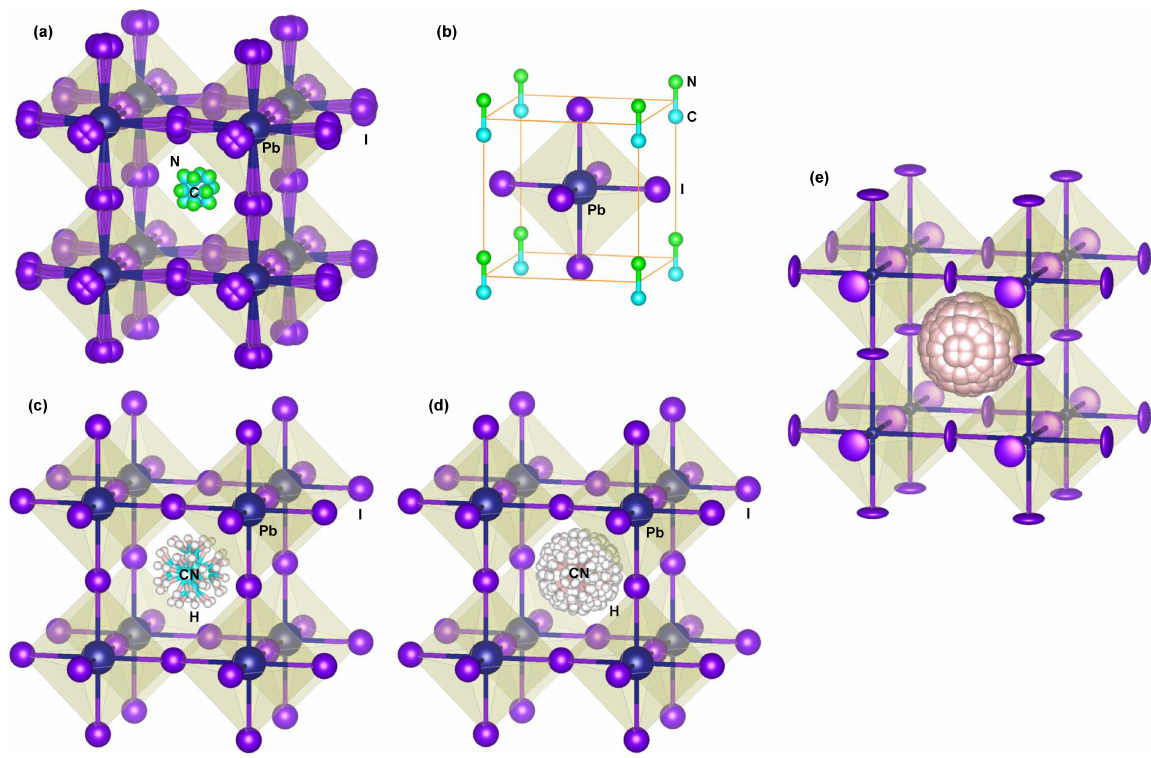
Figure 6: Structural models of cubic or pseudo-cubic CH 3 NH 3 PbI 3 corresponding to reported models in (a) [134], (b) [161], (c) [160], and (d) [159]. (e) Atomic displacement parameter ellipsoids shown at 50% probability of model